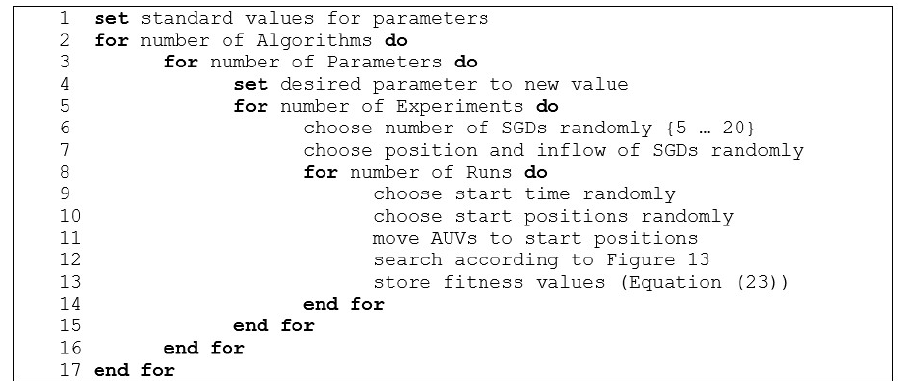
Figure 18. Pseudocode of experiments carried out.